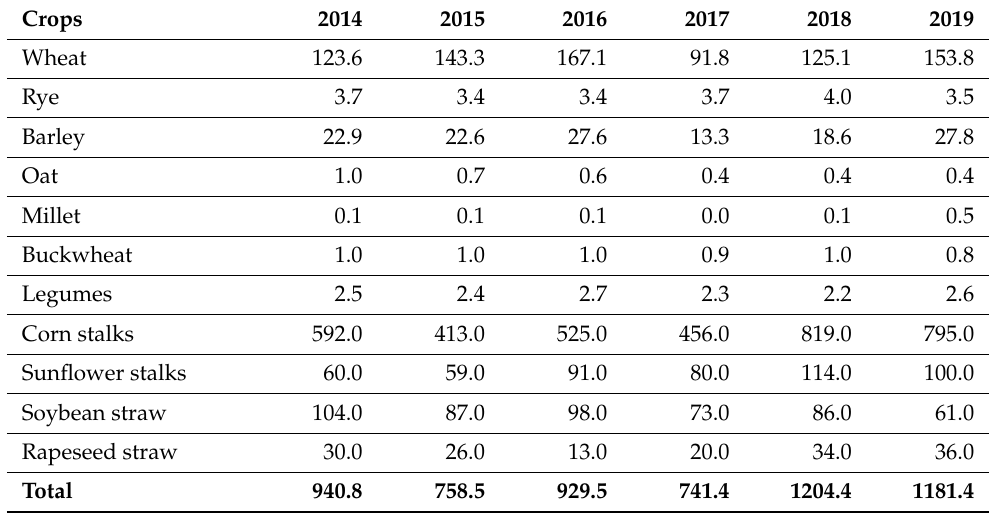
Table 3. The economic potential of grain and industrial waste, thousand